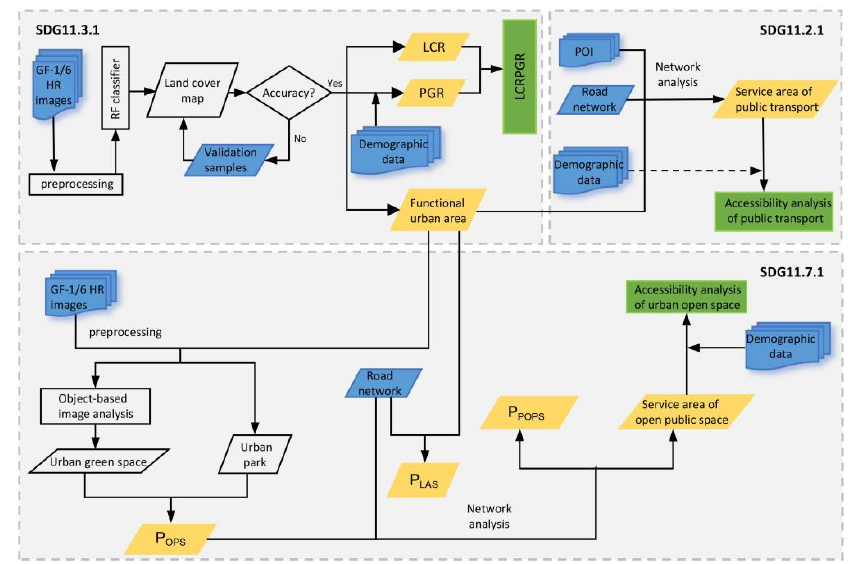
Figure 2. Workflow for SDG indicators assessment in this study.